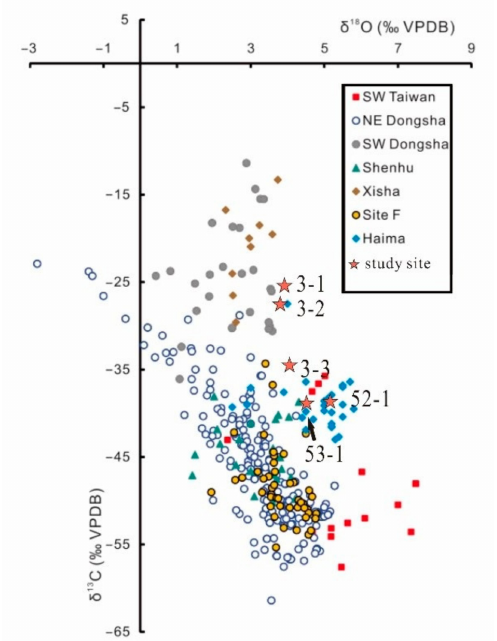
Figure 4. Stable carbon isotope ( δ 13 C) values and oxygen isotope ( δ 18 O) values of authigenic carbonates at deferent sediment layers. Shallowly buried samples (3–1, 3–2, and 3–3) have higher δ 13 C values (between − 33.8% (cid:24) and − 25.6% (cid:24) ) and lower δ 18 O values (between 3.6% (cid:24) and 3.8% (cid:24) ). The δ 13 C values of 53–1 and 52–1 are − 38.1% (cid:24) and − 38.0% (cid:24) . Modified from reference [31].